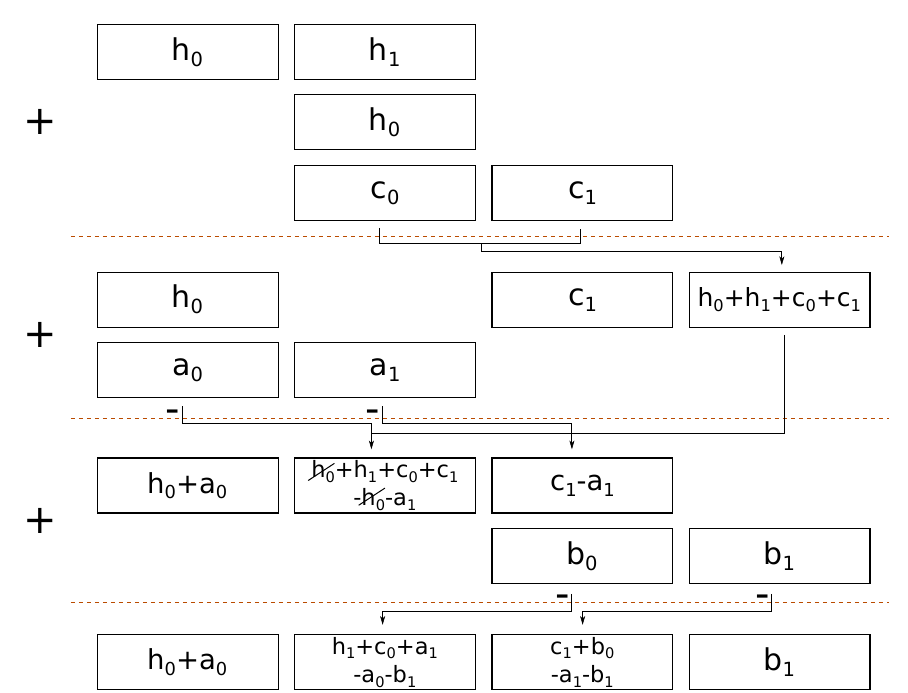
Figure 6: Details of the arrangements carried out over the output vector for Algorithm